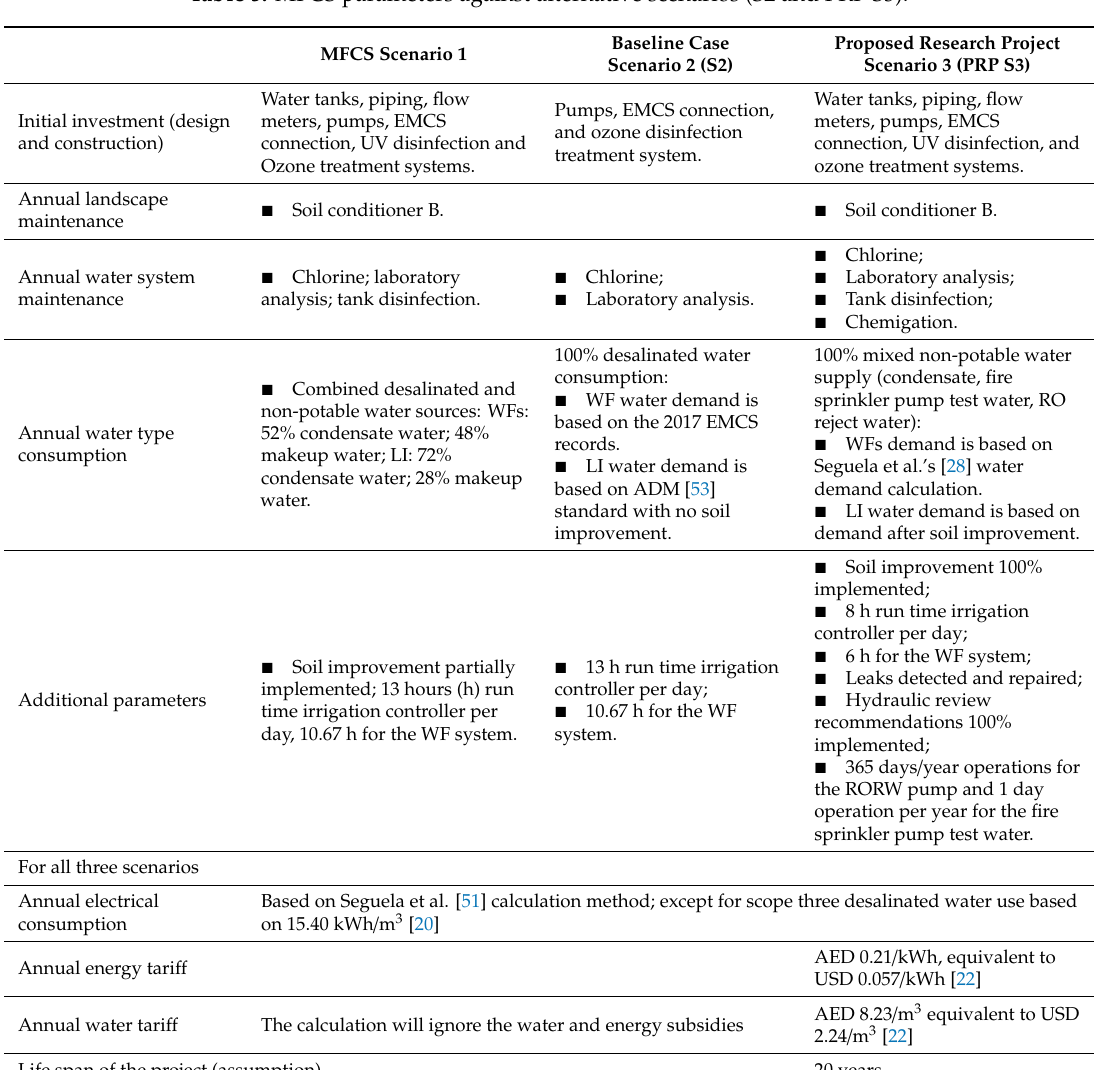
Table 5. MFCS parameters against alternative scenarios (S2 and PRP